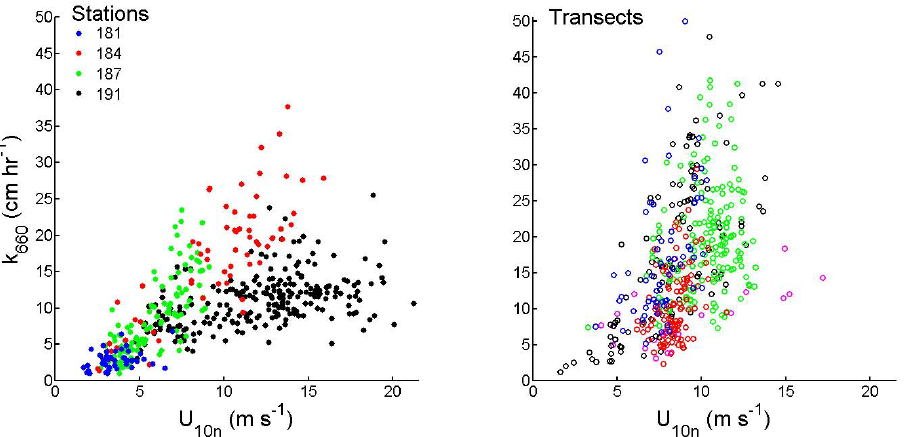
Fig. 4. Knorr_11 gas transfer coefficients plotted as a function of wind speed. The left panel shows data segregated into the individual stations as follows: stations 181 (blue), 184 (red), 187 (green) and 191 (black). The right panel shows data from underway transits segregated as follows: DOYs 179–180.8 (blue), 181.8–183.7 (red), 184.7–186.7 (green), 187.9–189.7 (black) and 193.2–193.4